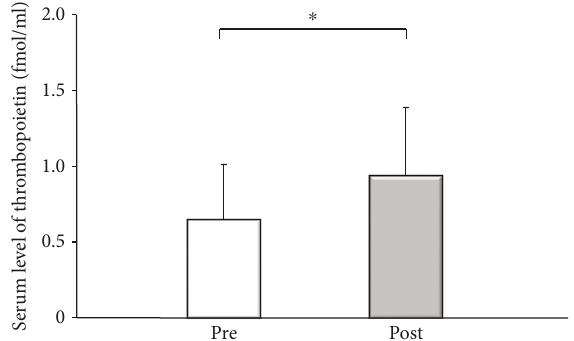
Figure 4: Serum level of vascular endothelial growth factor (VEGF) before and 4 weeks after partial splenic embolization (PSE). Serum VEGF increased signi fi cantly after PSE (from 108.8 ± 72 to 426.9 ± 382pg/ml: ∗ p = 0 0015 , by Wilcoxon ’ s test).